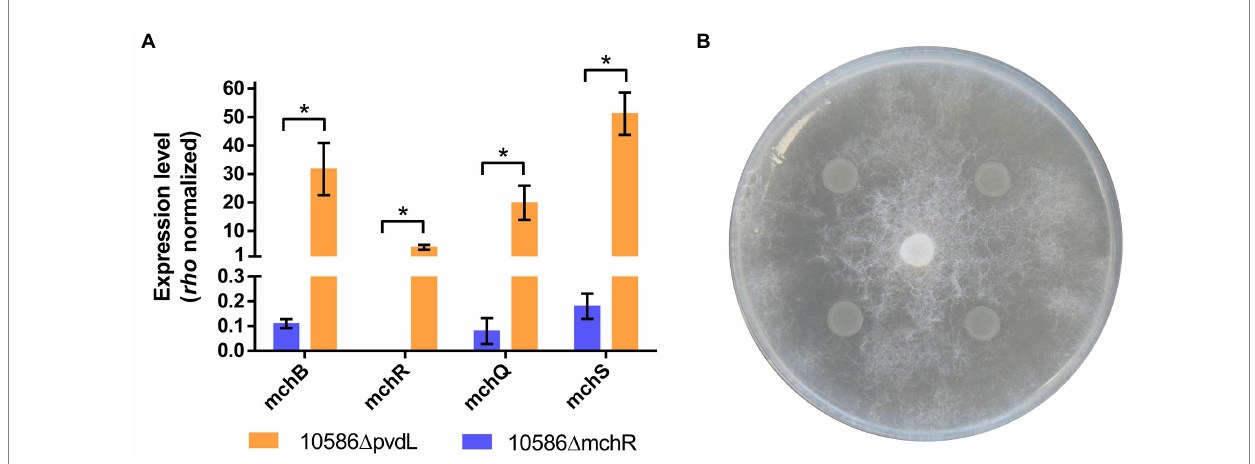
FIGURE 7 MchR is a transcriptional activator of the mch gene cluster. (A) Effect of mchR deletion on the levels of gene expression for mupirochelin biosynthesis gene mchB and both TonB-dependent receptors coding genes mchQ and mchS in the 10586 ∆ pvdL mutant in exponential growth phase ( n = 3). Compared to the 10586 ∆ pvdL mutant, absence of MchR biosynthesis in 10586 ∆ pvdL ∆ mchR leads to a strict repression of the mch gene cluster. Results of unpaired Student’s t-test with Welsh’s correction ns p > 0.05, * p < 0.05, ** p < 0.01, *** p < 0.001. (B) Antagonism assay of 10586 Δ pvdL Δ mchR against G. ultimum MUCL 38045. As expected, deletion of mchR is responsible for the loss of the strain anti- Globisporangium